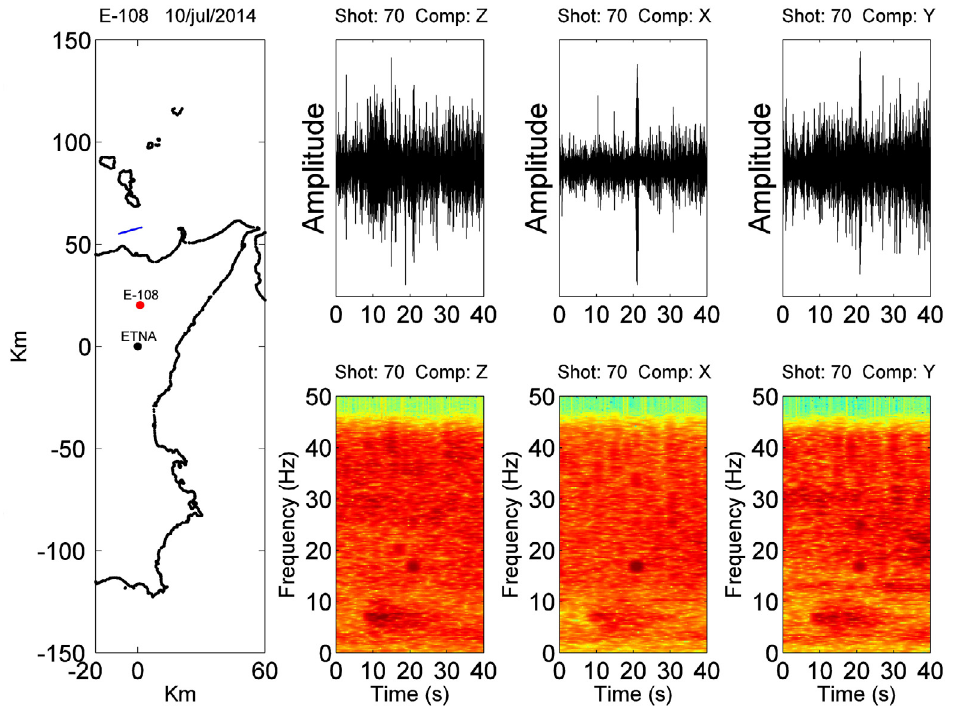
Figure 6. Example of standard noise register of three components X, Y and Z before filtering. Registers from CUBE-station E-109 depicted in time and frequency domains.